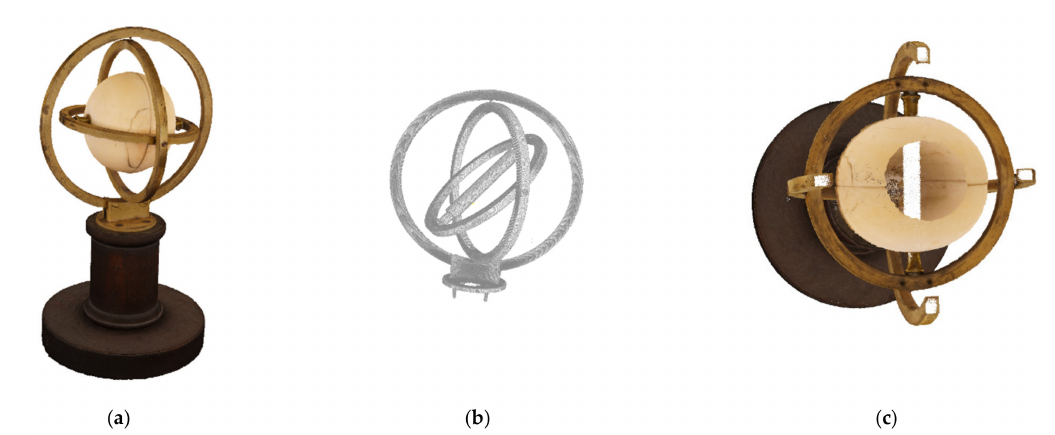
Figure 24. The 3D digital twin of the Machine of Bohnenberger: ( a ) meshed point cloud of CV/photogrammetry; ( b ) iso- surface of the gimbal CT scan; and ( c ) split view of the CT/CV integrated